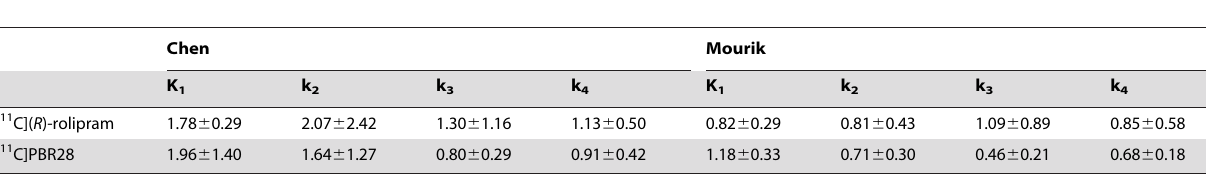
Table 3. Image/blood ratio of the individual rate constants obtained with an unconstrained two-tissue compartment model.